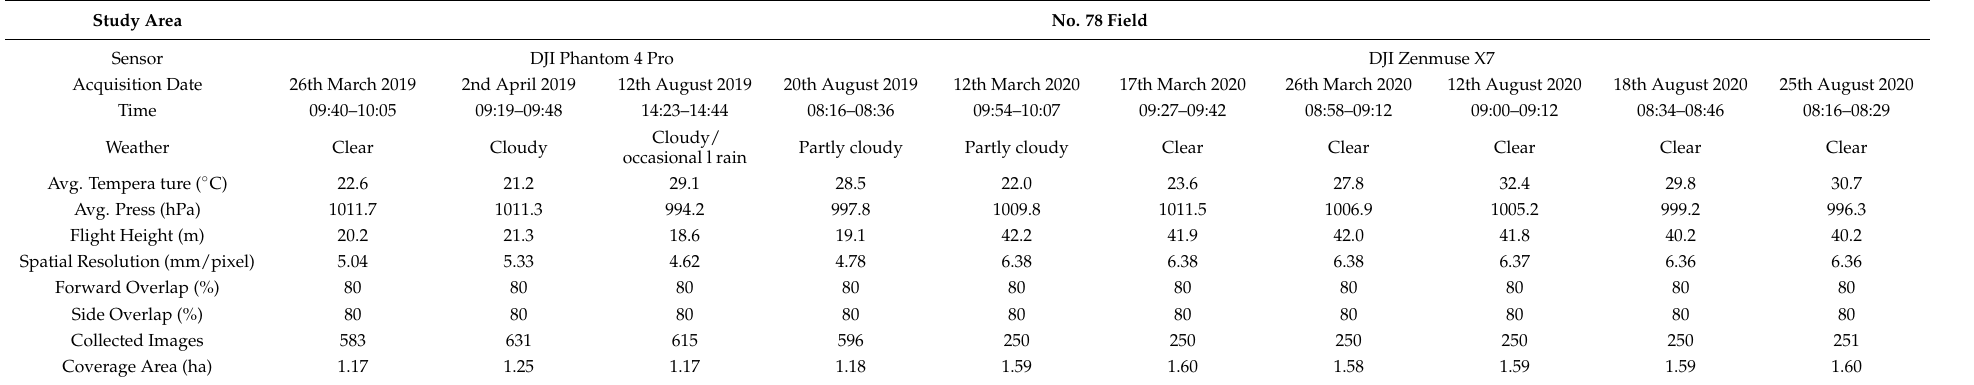
Table 4. Information of UAV expansion data collection